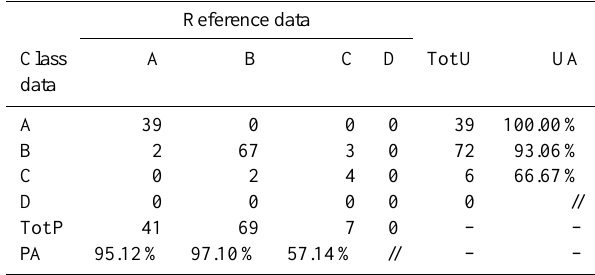
Table 6. Confusion matrix for the radial basis function network classifier evaluated on the test set TeS (cid:127) with elevation between 1000 and 1300m; Class A: absence of snow cover, Class B: 1– 10cm, Class C: 11–90cm, Class D: greater than 90cm.